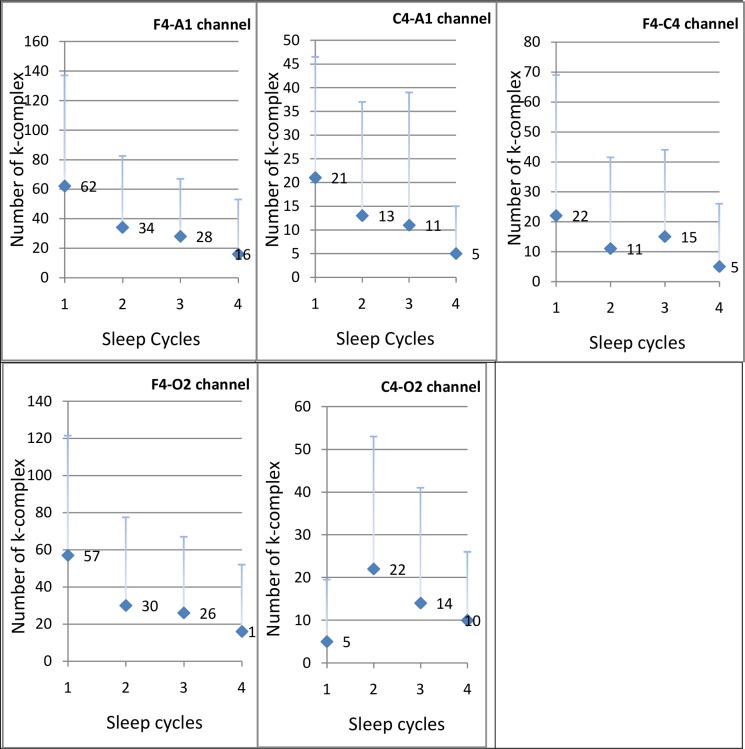
Trend of probe-specific K-complex numbers across sleep cycles.Each panel represents the probe-specific K-complexes across different cycles. The Y-axis shows the means and standard deviations of absolute numbers of K-complexes. The X-axis shows the first four cycles of the sleep stages.